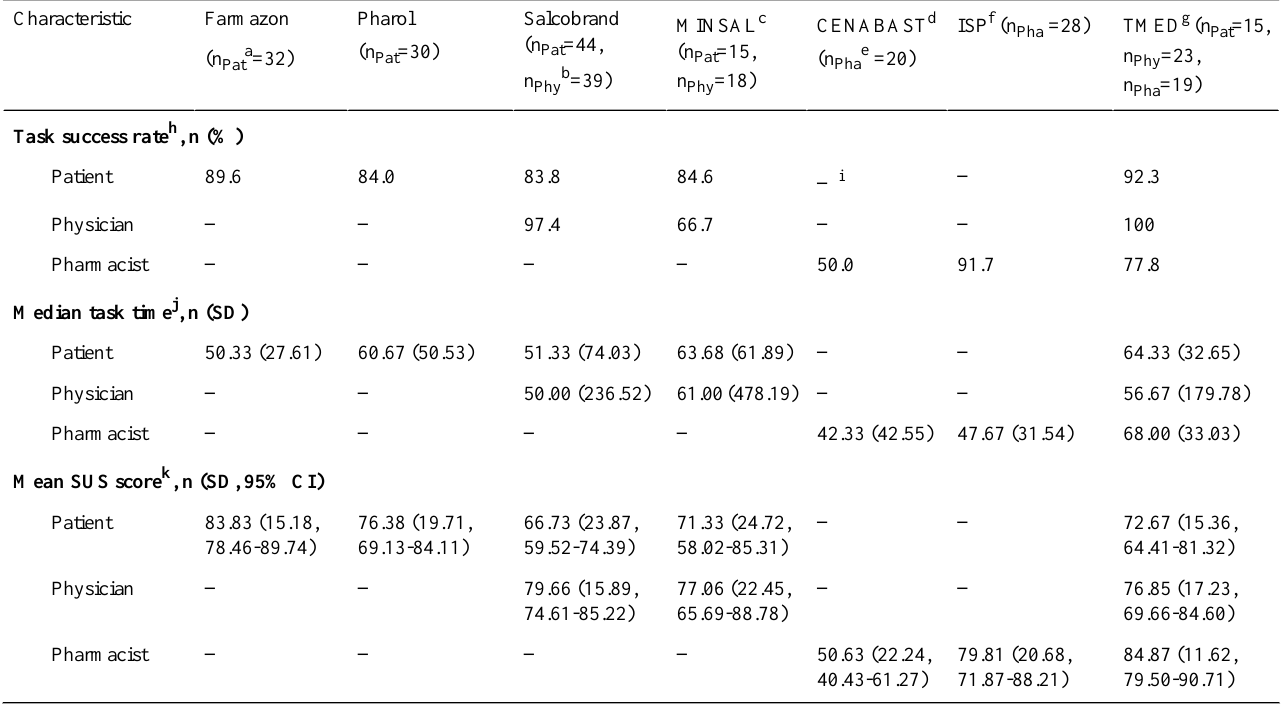
Table 2. Overview of task success, task time, and system usability scale scores for all user groups by online consumer medication information system.